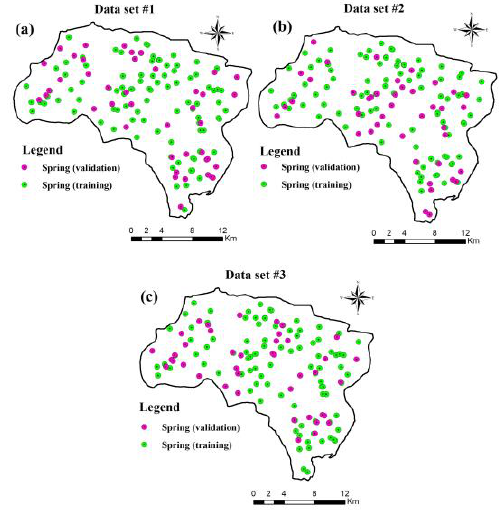
Figure 3. Sites included in the three sample datasets (S1–S3) used for modeling in the study area, ( a ) Data set 1; ( b ) Data set 2; ( c ) Data set 3.